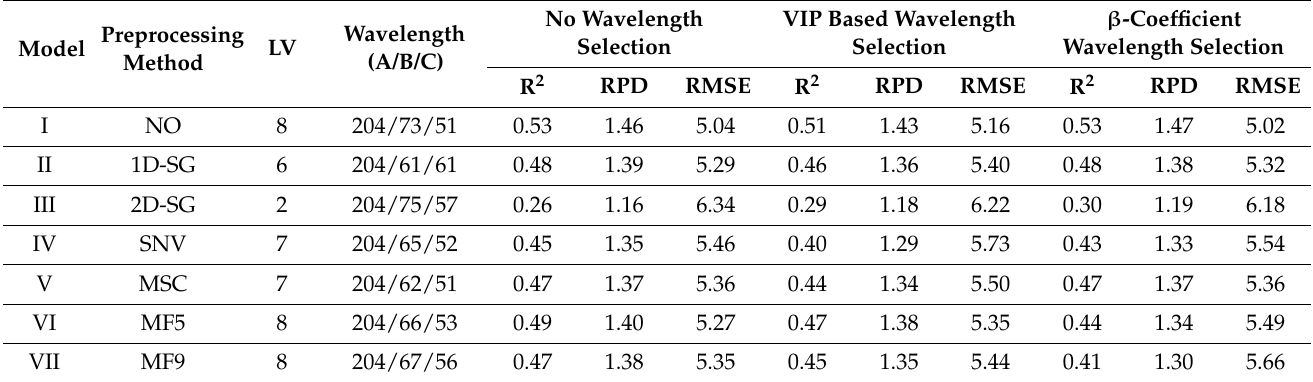
Table 1. The PLSR results when considering the full HSI wavelengths between 397.32 and 1003.58 (a total of 204 spectral